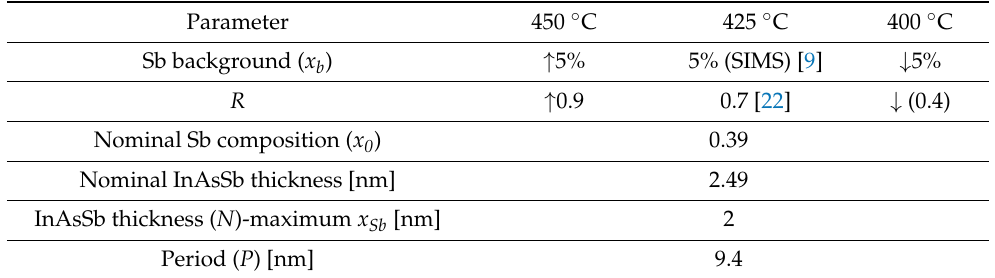
Table 2. Muraki’s Sb distribution profile for T2SLs InAs/InAsSb for Set I samples 4, 5, and 6.